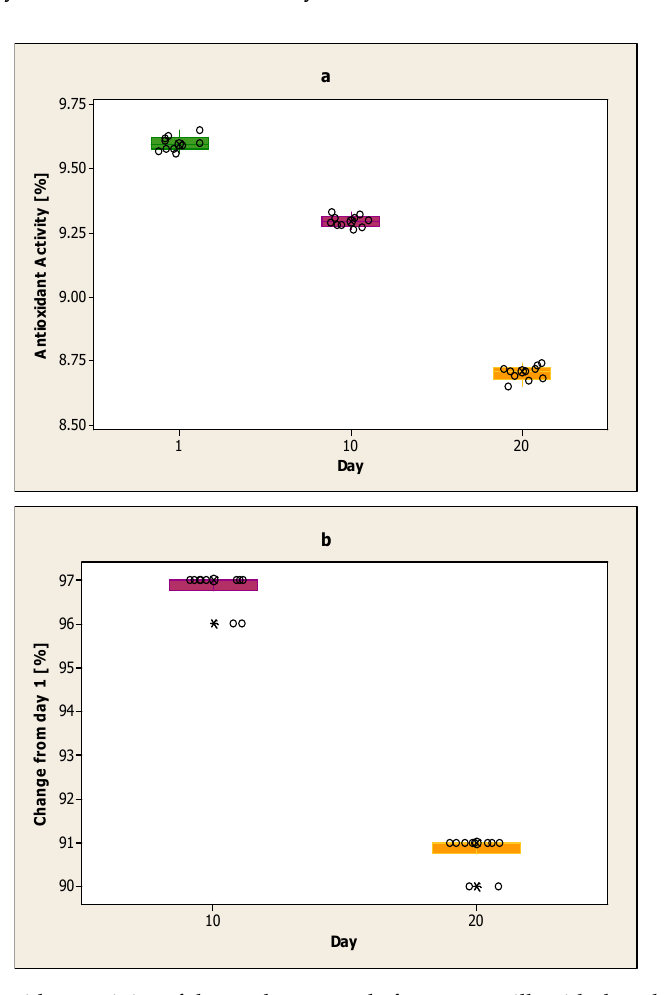
Figure 3. ( a ) Antioxidant activity of the yoghurt sample from cow milk with the addition of volatile basil oil encapsulated in sodium alginates on the first day, the 10th day and the 20th day; ( b ) Decline on day 10 and day 20 for the yoghurt sample from cow milk with the addition of volatile basil oil encapsulated in sodium alginates compared to day